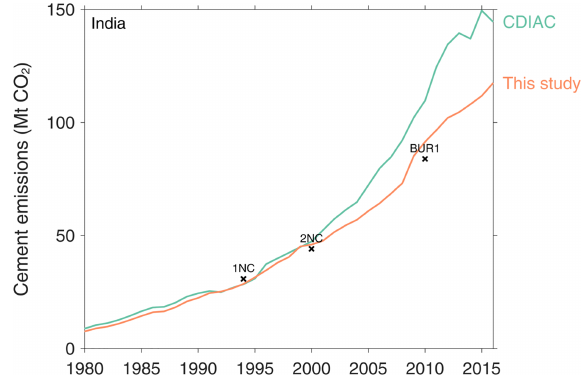
Figure D8. Comparison of Indian cement production data (in kilo- tonnes) from USGS and OEA, the latter from 2005. Figure D9. Revised cement emissions for India. 1NC: first national communication; 2NC: second national communication; BUR1: first biennial update report.